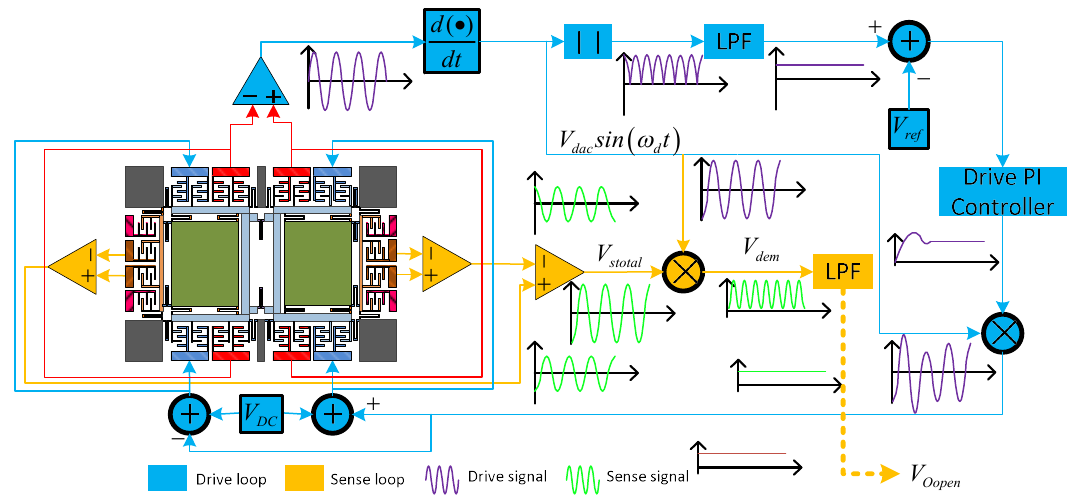
Figure 3. Gyro system schematic diagram.